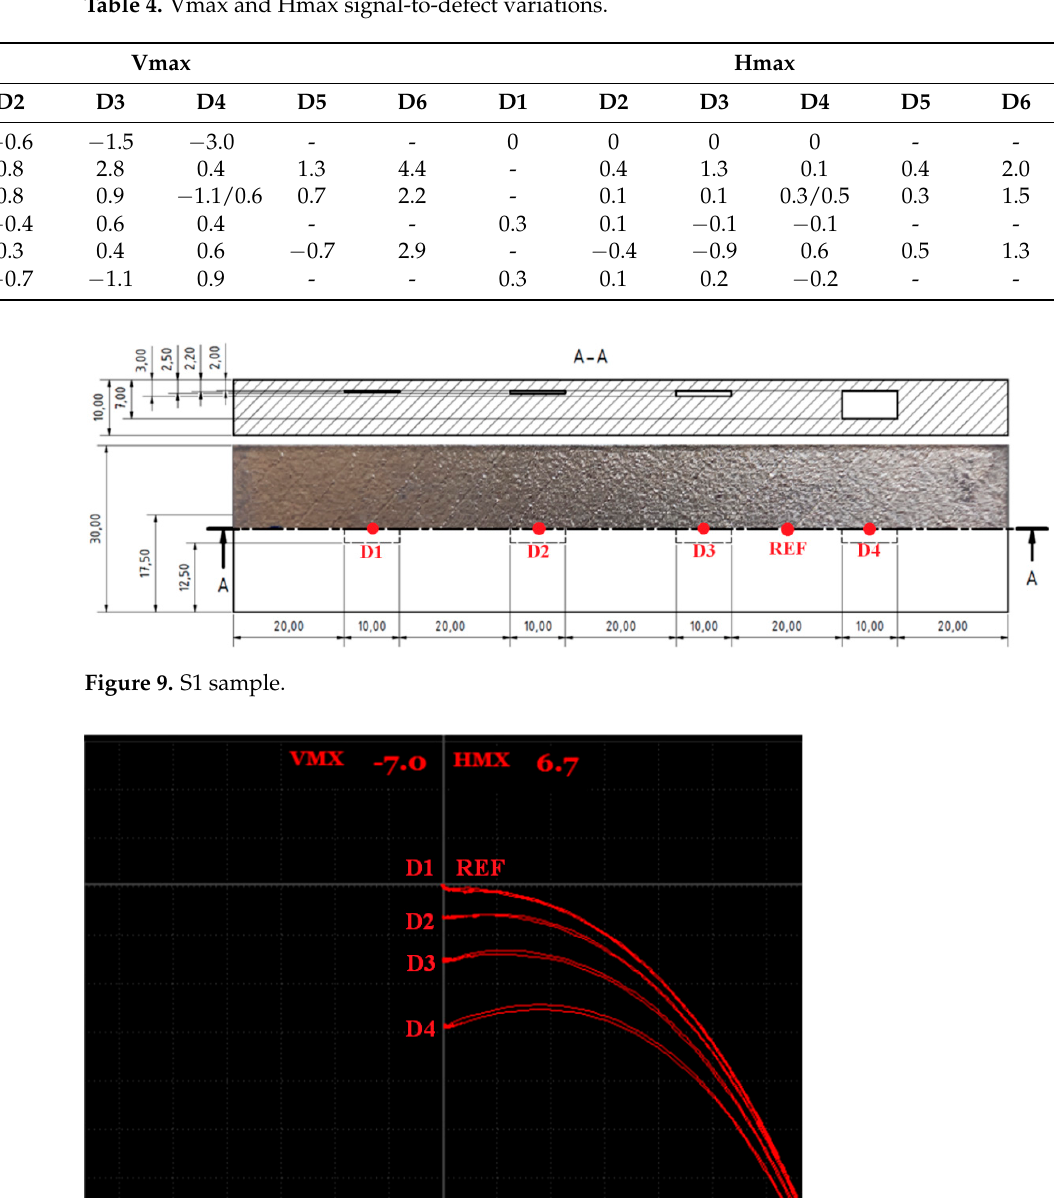
Table 4. Vmax and Hmax signal-to-defect variations.